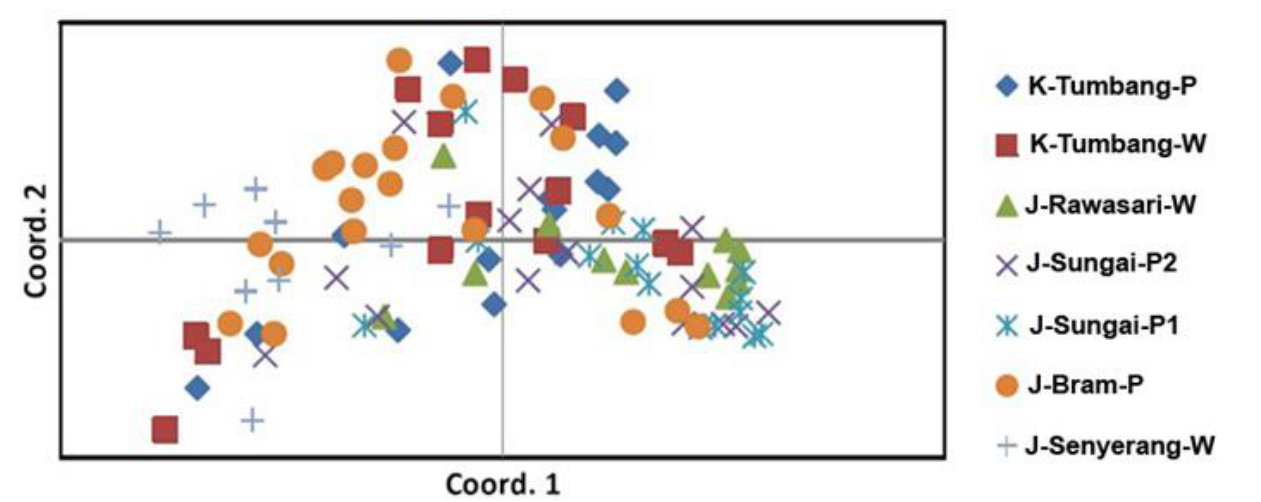
Figure 3. Principal coordinates analysis (PCoA) of the seven Dyera polyphylla populations. The population codes are explained in Table 1.